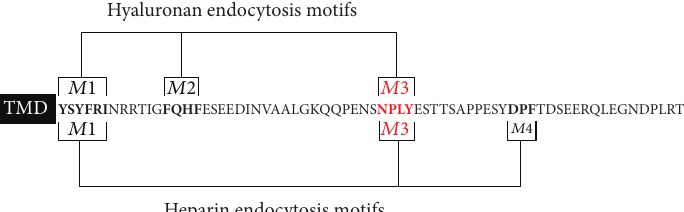
Figure 7: Different sets of HARE CD endocytic motifs are functional during HA versus Hep endocytosis. The four HARE endocytic motifs (boldface) examined are denoted by M1 (YSYFRI 2485 ), M2 (FQHF 2495 ), M3 (NPLY 2519 ), and M4 (DPF 2534 ). The two different subsets of three of these motifs active in the coated pit mediated endocytosis of HA ( M1, M2, and M3 ) or Hep ( M1, M3, and M4 ) are highlighted by brackets. M3 is highlighted in red to indicate its special significance as the only motif of the three we were able to test ( M2, M3, and M4 ) that enabled HARE to target coated pit mediated endocytosis of both HA and